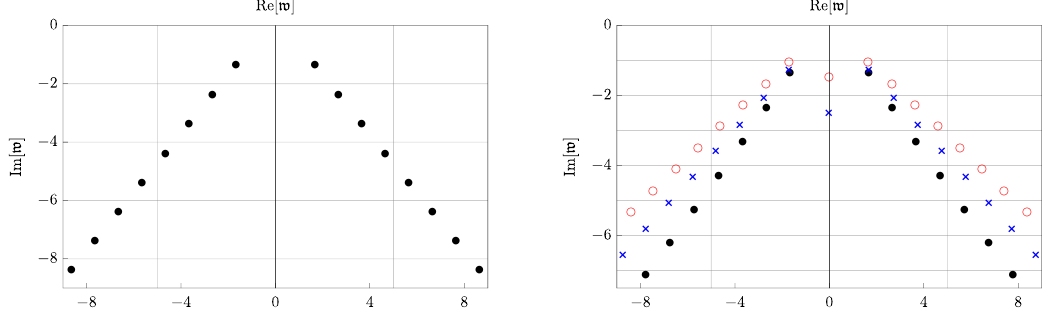
Figure 3 . The scalar channel quasinormal spectrum at (cid:11) = 0, q = 0 : 5 (left panel) and in the theory truncated at O ( (cid:11) ), i.e. at (cid:11) 6 = 0, (cid:13) 2 = 0, q = 0 : 5 (right panel), plotted for (cid:11) = 0 : 01 (black dots), (cid:11) = 0 : 05 (blue crosses) and (cid:11) = 0 : 1 (red